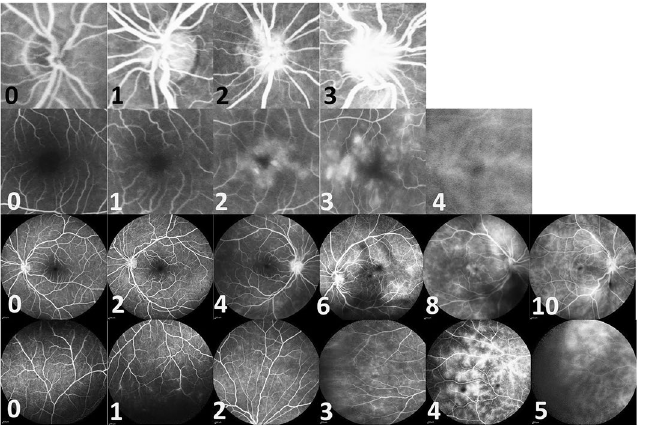
Figure 1. Examples of FA scoring system for grading of inflammatory activity. The numbers below each figure represent the scores. The first row shows the optic disc Hyperfluorescence grading, 0–3 (from left to the right; 0: normal, 1: partial staining of the disc, 2: diffuse leakage without blurring of the disc margin, 3: diffuse leakage and blurring of the disc margin.) The second row shows macular leakage grading, 0–4 (from left to the right; 0: no perifoveal hyperfluorescence, 1: incomplete ring of leakage, 2: complete (360°) leakage but less than 1 disc diameter (DD) wide, 3: complete (360°) leakage of 1–1.5 DD wide, 4: complete (360°) leakage of more